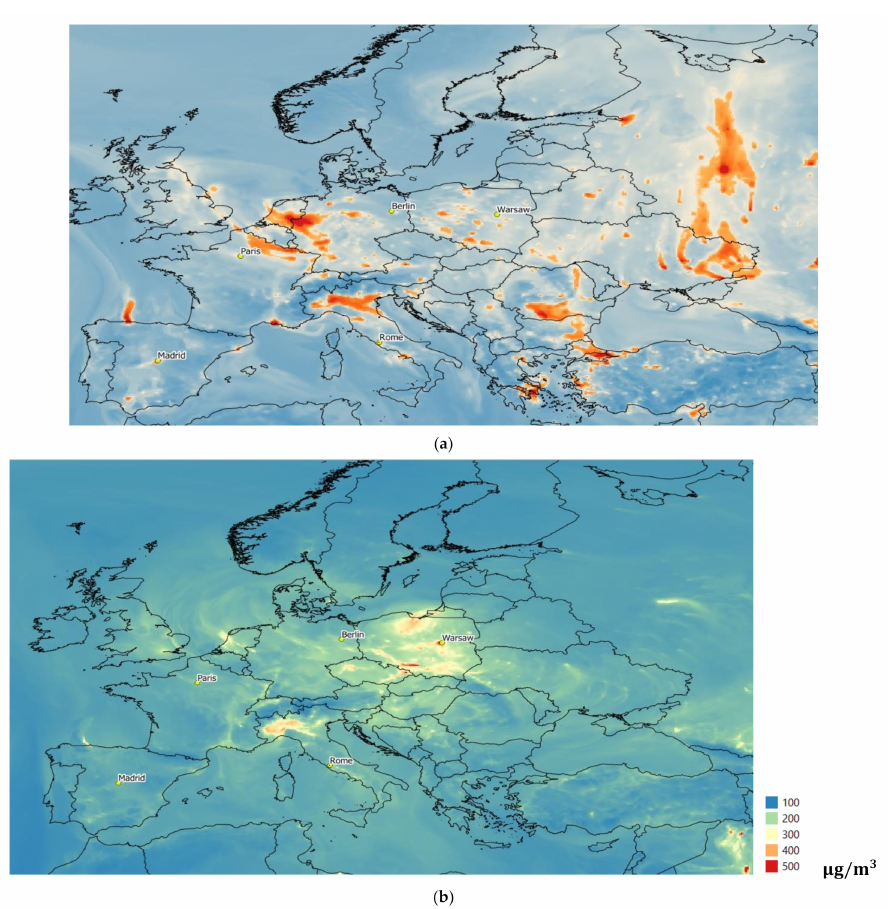
Figure 10. Thermal maps of CO concentration on ( a ) 5 April 2018, and ( b ) 5 April 2020. Source: Own elaboration, based on data from Copernicus Atmosphere Monitoring Service (CAMS) [47]. The concentration level in the analyzed period in Poland decreased, which is shown in Figure 11. The largest decrease was recorded on 30 March 2020, when the concentration decreased by about 40%, compared to 2018. The average decrease on 20 March to 15 April was 12%.